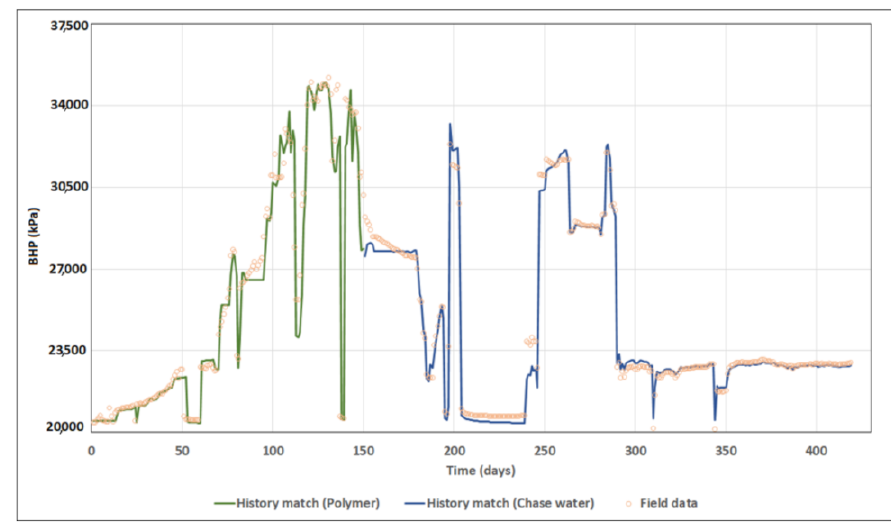
Figure 24. History matching BHP of polymer injection and chase